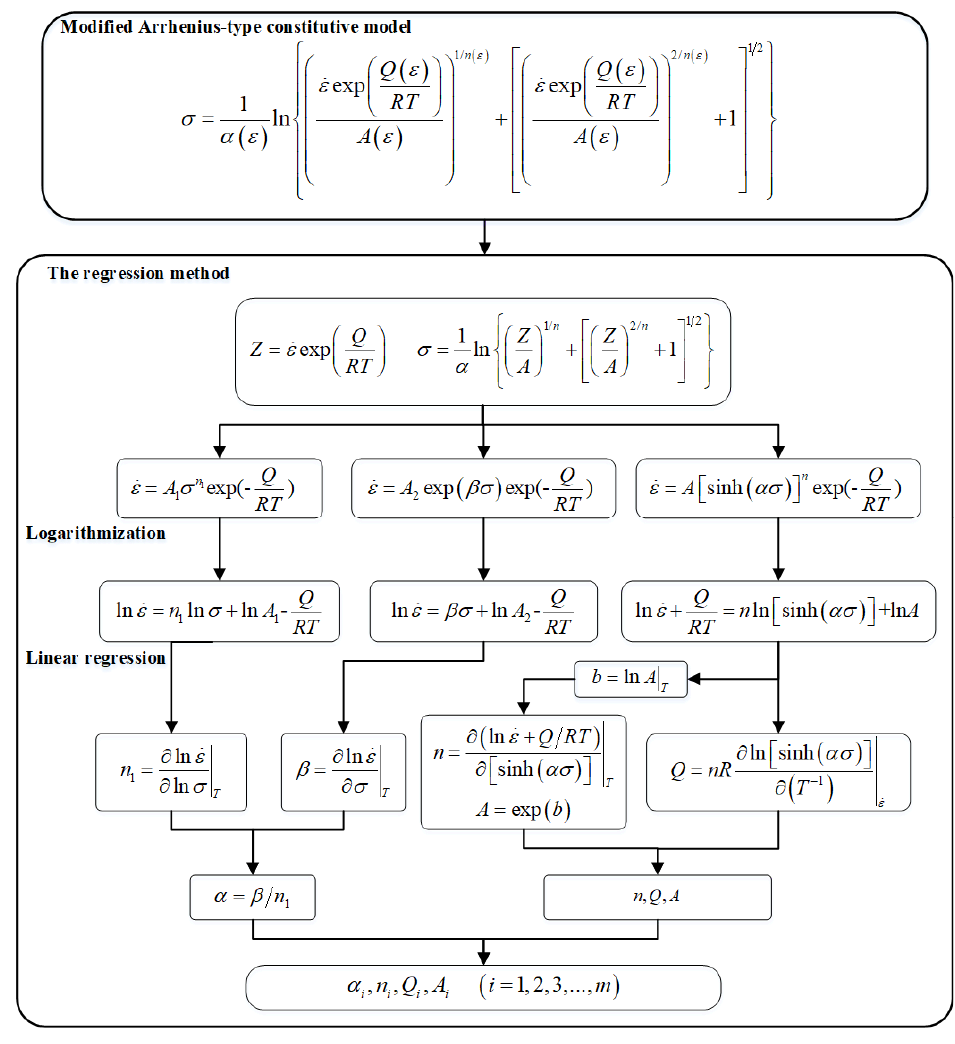
Figure 4. Flowchart of material constants’ calibration implementation by regression method.